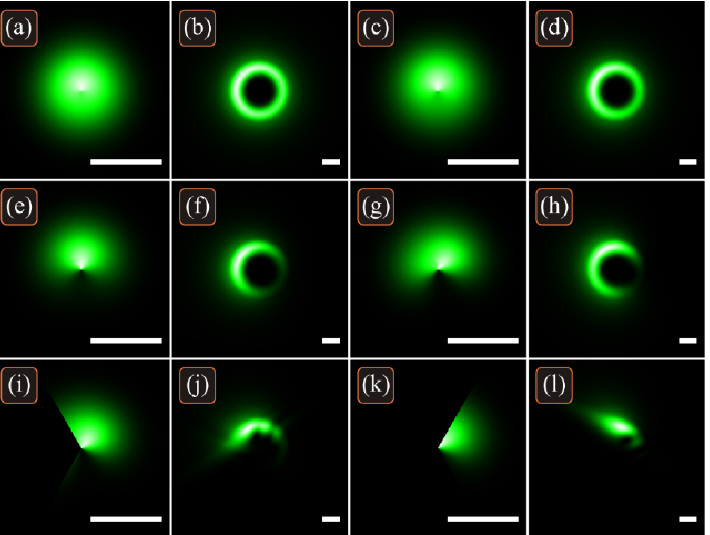
Figure 1. Intensity distributions of the beam (1) in the initial plane (columns 1 and 3) and at the Rayleigh distance from it (columns 2 and 4), when the side components in the OAM spectrum increase ( a – f ), when the OAM spectrum widens ( g , h ), and when the initial beam is truncated by a sector aperture ( i – l ). The length of the horizontal line segment is 1 mm.